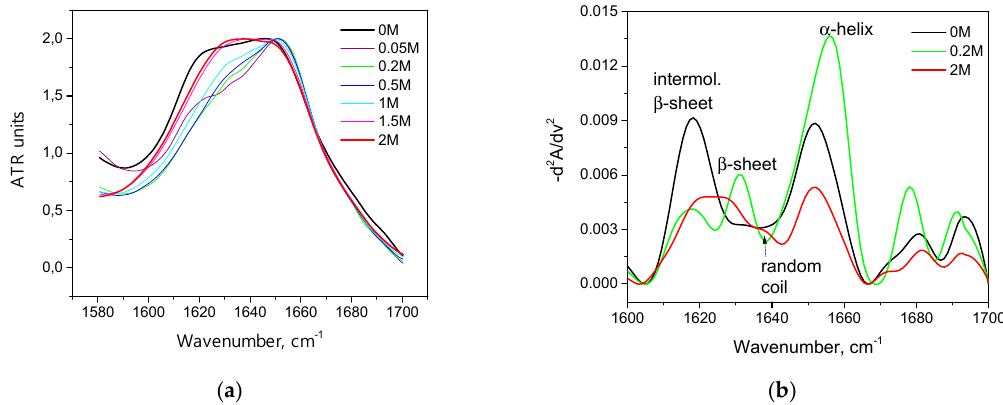
Figure 11. Changes in the character of the Amide I band ( a ) and changes in the second derivative of the Amide I band ( b ) of HSA in 10% wt. aqueous solution at 80 °C with various concentrations of KSCN. Only the most representative curves are shown for the sake of clearness.